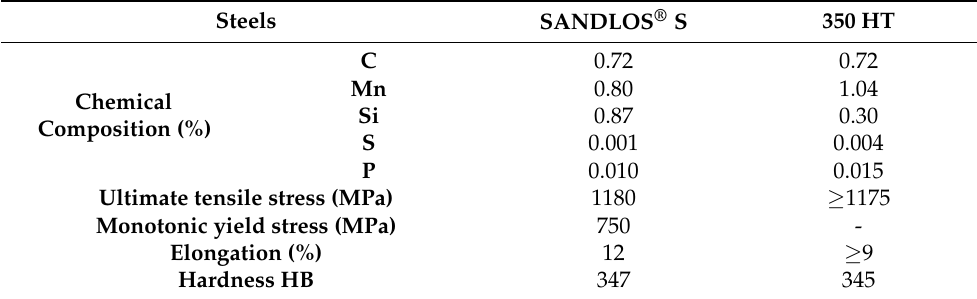
Table 1. Main chemical elements and mechanical properties of the wheel and rail